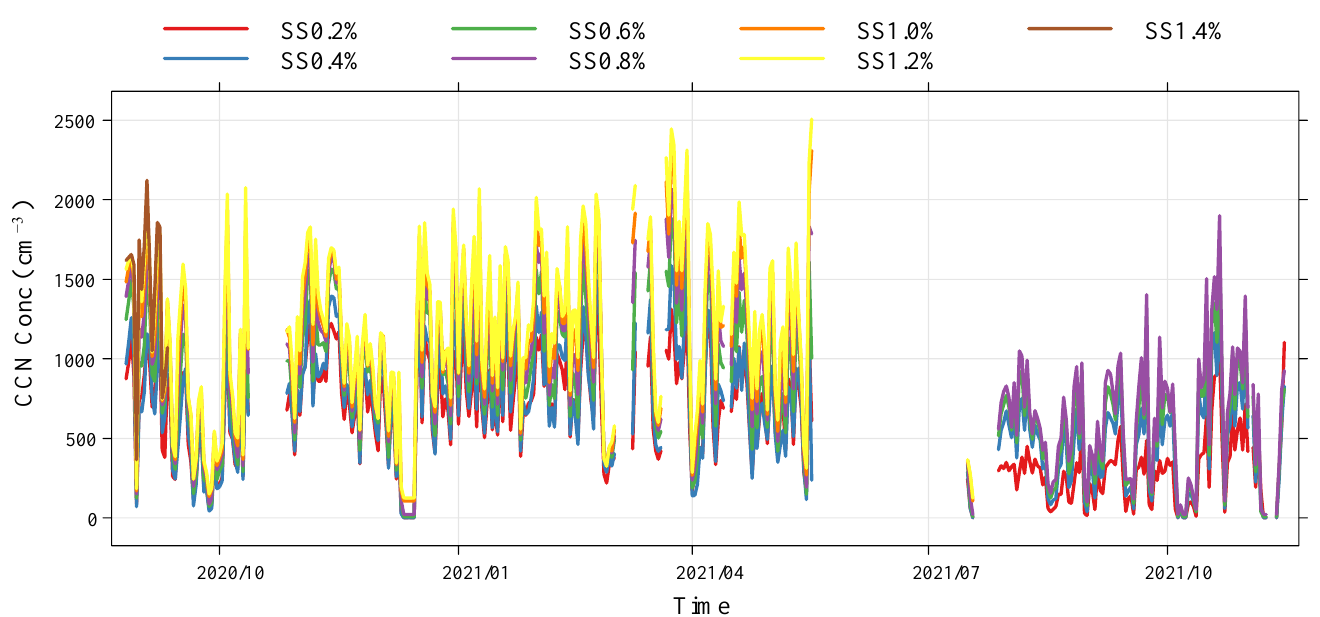
Figure 3. Temporal variation in CCN concentrations at different supersaturation levels from August